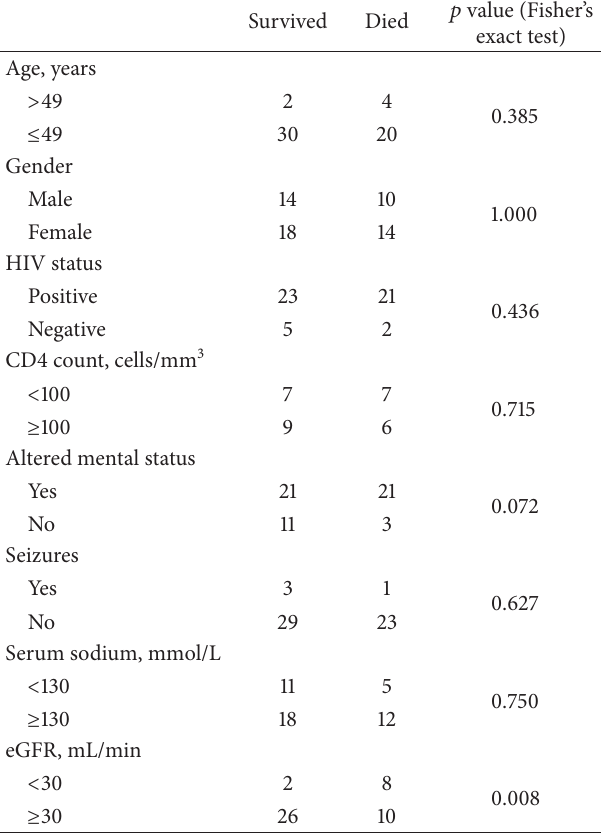
Table 3: Analysis of factors associated with in-hospital